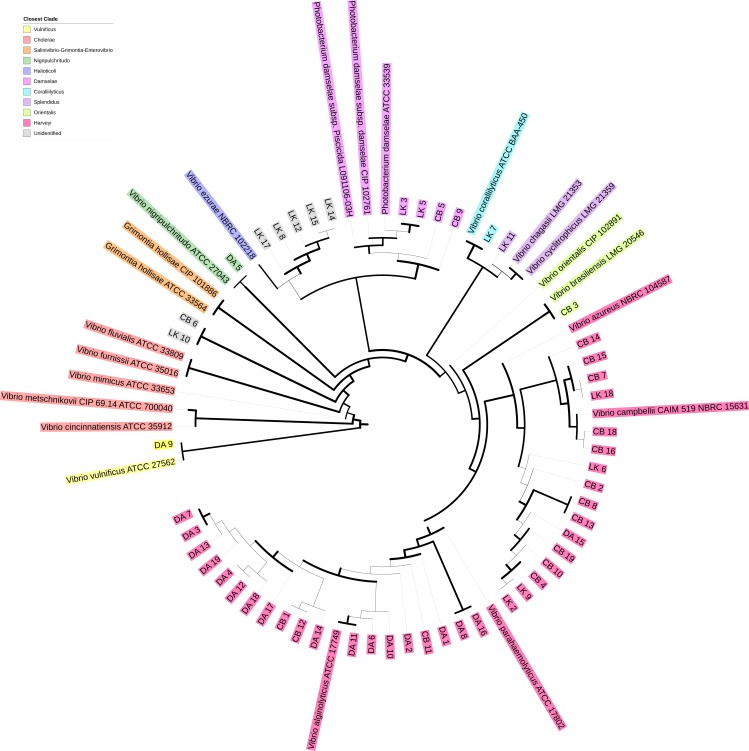
Phylogenetic tree of hsp60 sequences of presumptive Vibrionaceae isolates.Vibrionaceae with previously published hsp60 sequences (cpnDB; http://cpndb.ca/; Accessed May 02, 2018) are indicated by their genus and specific epithet (accession numbers listed in Data S1). Branch thickness corresponds to aLRT SH-like branch support (thick line ≥ 0.5 (most support), intermediate line = 0.5, and thin line ≤ 0.5 (least support)) (Guindon et al., 2010).